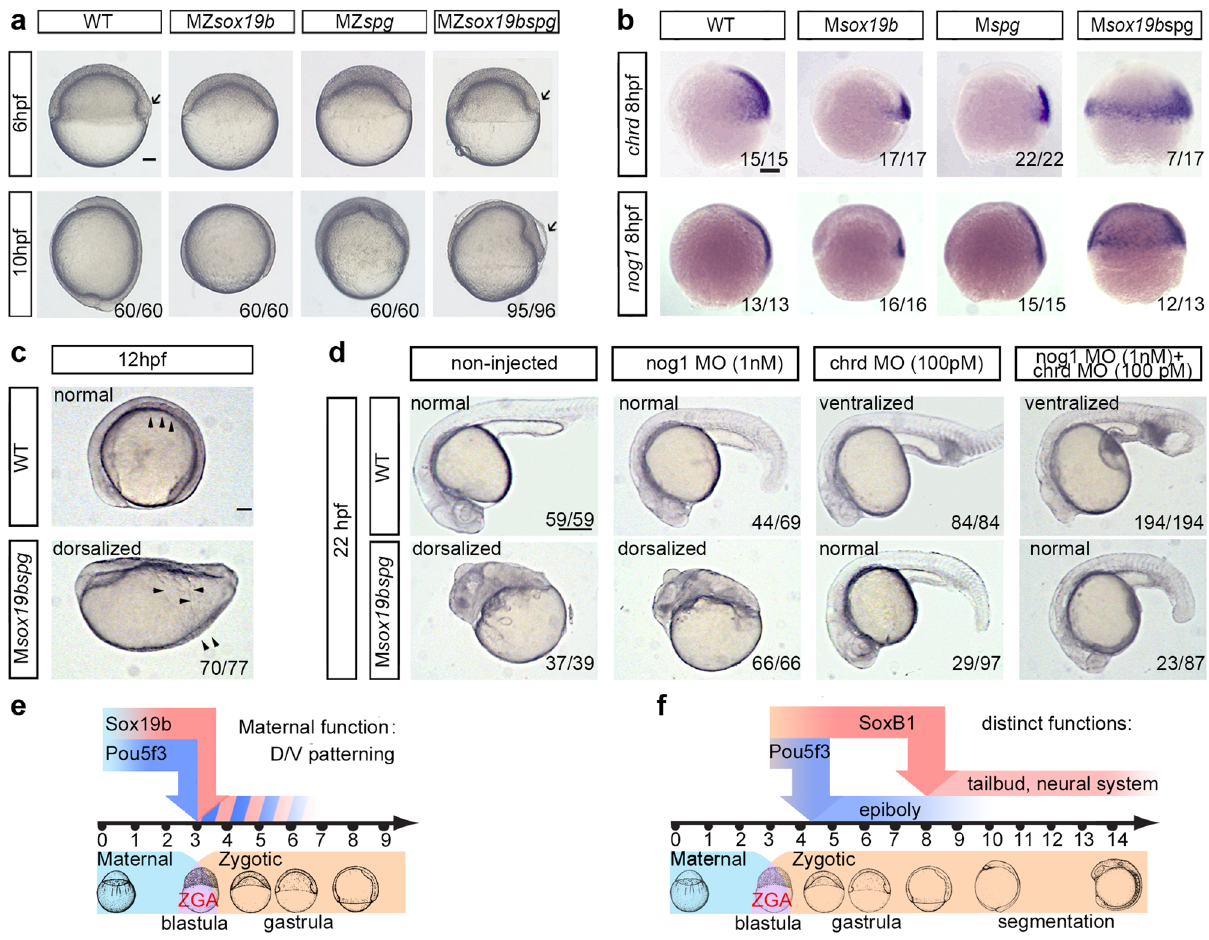
Fig. 2 Maternal Pou5f3 and Sox19b safeguard correct dorso-ventral patterning. a Comparison of the single mutants, double mutant and wild-type embryos. 10hpf: MZ sox19bspg mutants are arrested in gastrulation similarly to MZ spg . Arrow shows abnormally enlarged shield in MZ sox19bspg . b , c Double maternal mutants M sox19bspg are dorsalized. b In situ hybridization for dorsal markers noggin1 and Chordin, lateral views, dorsal to the right. Note the circumferential expansion in the M sox19bspg . c Somites (arrowheads ) form on the dorsal side in WT, but spread over the M sox19bspg embryo. Dorsal up, anterior to the left. d Normal development of M sox19bspg mutants can be rescued by reducing Chordin, but not Noggin1 levels. The wild-type or M sox19bspg embryos were injected with the indicated morpholinos or non-injected. The numbers show the ratio of embryos with indicated phenotype/ all embryos alive at 22hpf. The arrows show abnormally expanded blood progenitor cells in the ventralized wild-type embryos. Anterior to the left, dorsal up. e , f Combinatorial ( e ) and distinct ( f ) functions of Pou5f3 and SoxB1. e Maternal Sox19b and Pou5f3 safeguard correct D/V patterning. f Pou5f3 is critical for epiboly